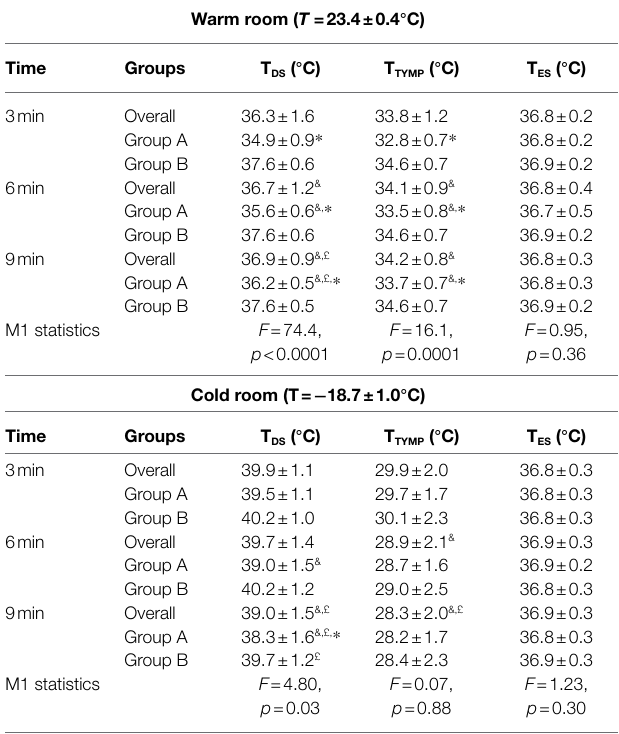
TABLE 1 | Time course of temperature values measured by the Double Sensor (T DS ), tympanic (T TYMP ), and esophageal sensors (T ES ) in the warm and cold room settings for the whole population and in the two randomization groups (group A: exposure to cold followed by warm room setting; group B: exposure to warm followed by cold room setting). Warm room ( T = 23.4 ± 0.4 °